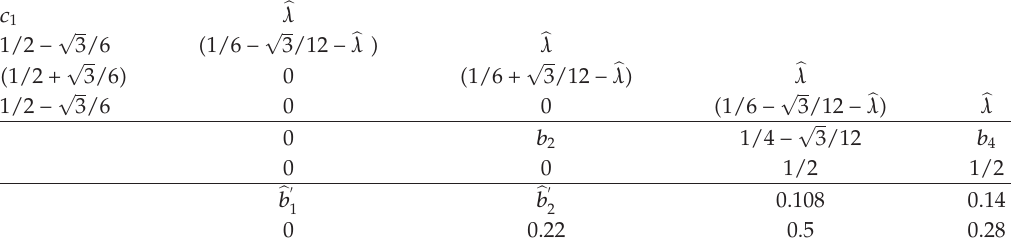
Table 3: The DIRKN4 (cid:2) 3 (cid:3) 8New method.